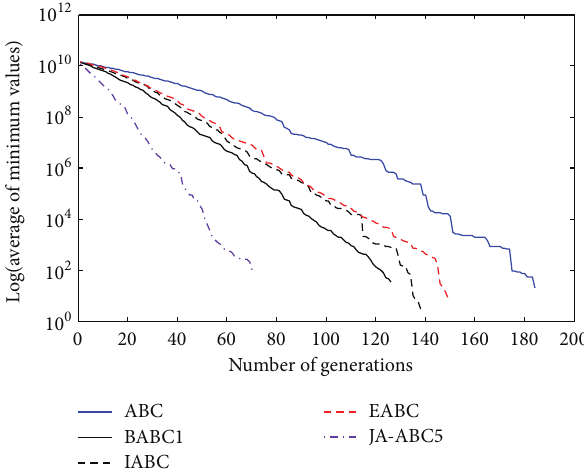
Figure 3: The convergence rates of optimization algorithms on Himmelblau function.